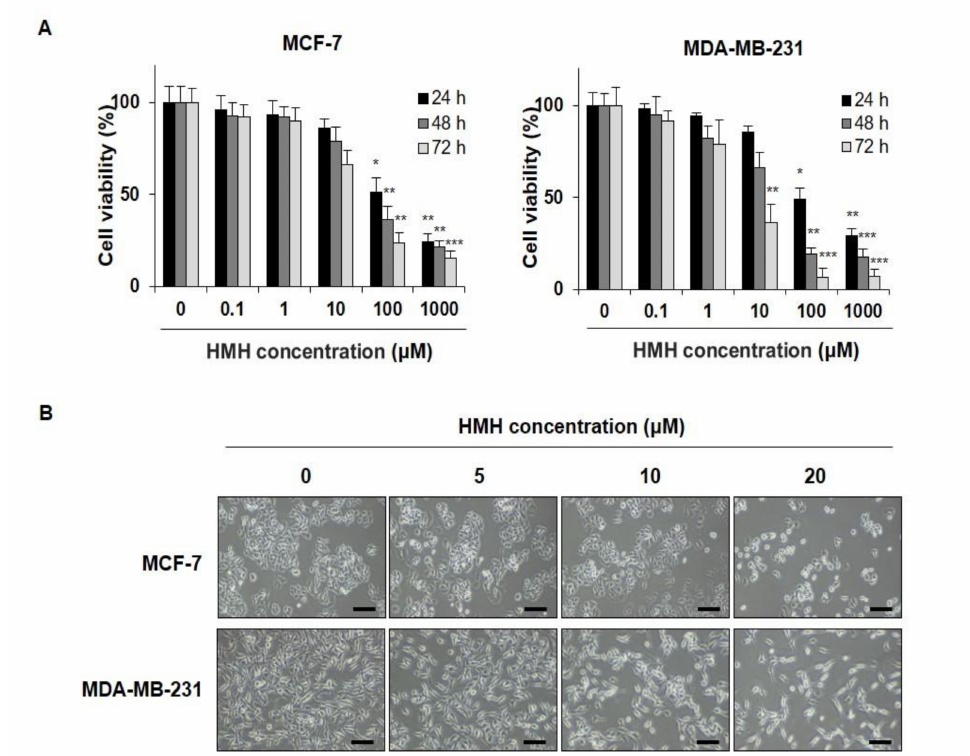
Figure 2. Effects of harmine hydrochloride on the growth of human breast cancer cell lines—MCF-7 and MDA-MB-231. ( A ) Cell survival curve in breast cancer cell lines following harmine hydrochlo- ride treatment. The cells were cultured with 0, 1, 10, 100, and 1000 µ M harmine hydrochloride for 24, 48, and 72 h, followed by measurement of cell proliferation through MTT analysis. ( B ) Morpho- logical changes. Harmine hydrochloride suppressed the growth of MCF-7 and MDA-MB-231 cells in a dose-dependent manner to reduce cell density. Results are expressed as mean ± SD. Statistical differences were analyzed using Student’s t -test (* p < 0.05, ** p < 0.01, *** p < 0.001 vs. control). Cell morphology was visualized by inverted microscopy (200 × ). Scale bar, 50 µ